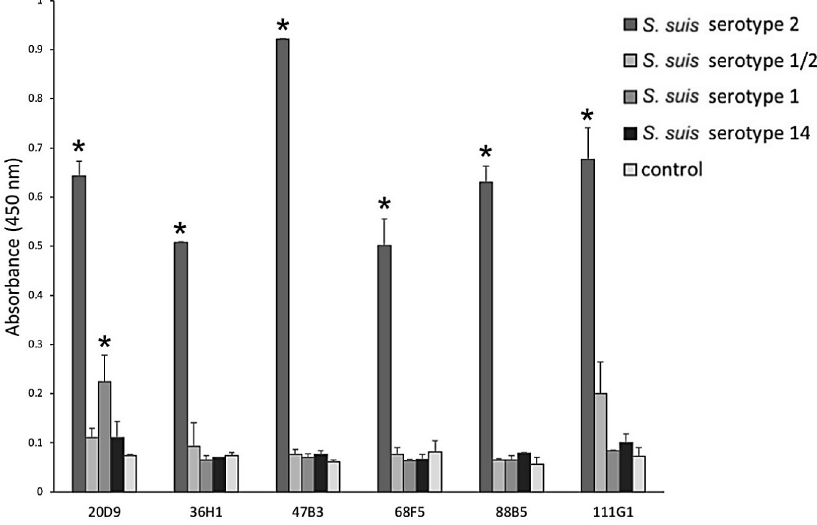
Fig 4. Cross-reactivity of the six positive clones (20D9, 36H1, 47B3, 68F5, 88B5, and 111G1) against S . suis serotypes 2, 1/2, 1, and 14, as tested by ELISA. Data are shown as the mean ± SD (n = 3). � P < 0 . 05 compared to the negative